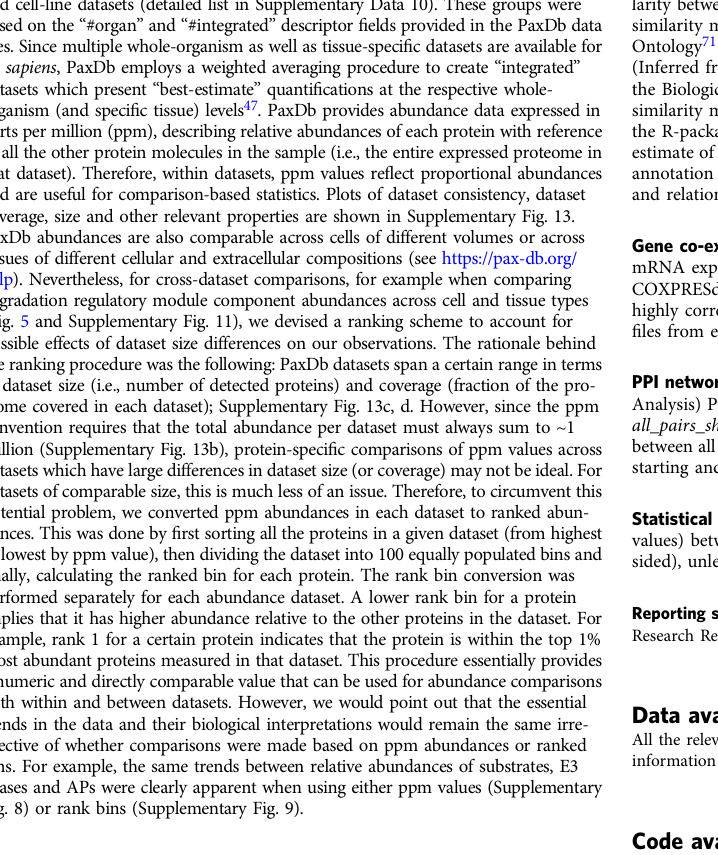
categories: integrated datasets, whole organism datasets, tissue/organ-speci fi c datasets and cell-line datasets (detailed list in Supplementary Data 10). These groups